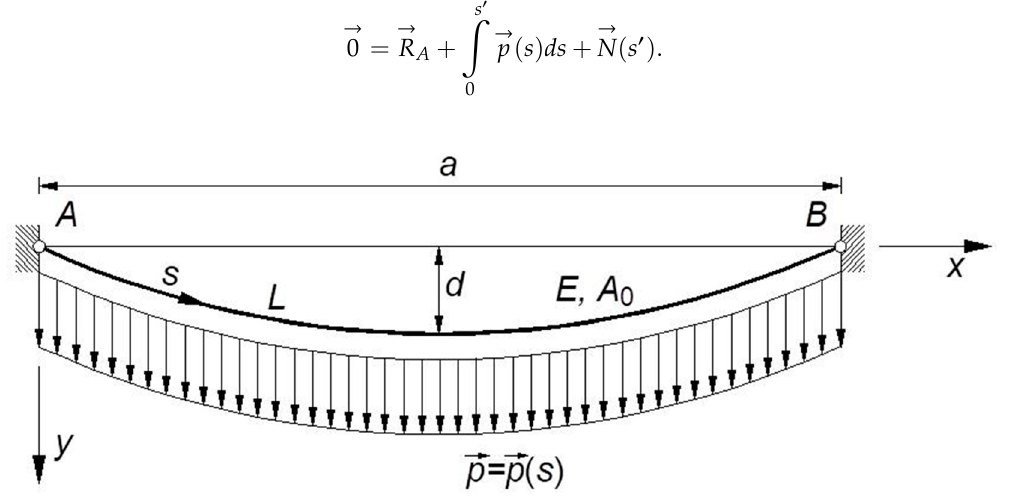
Figure 1. Deformed configuration of a horizontal cable due to self-weight.